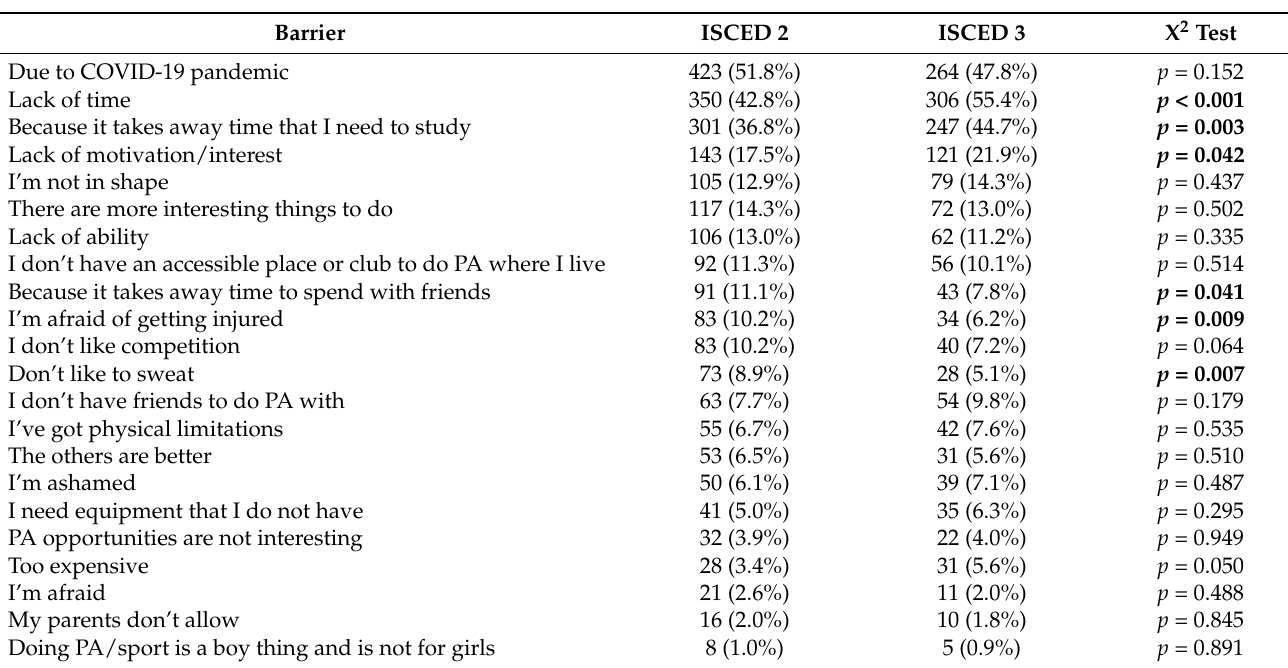
Table 3. PA barriers stratified by level of